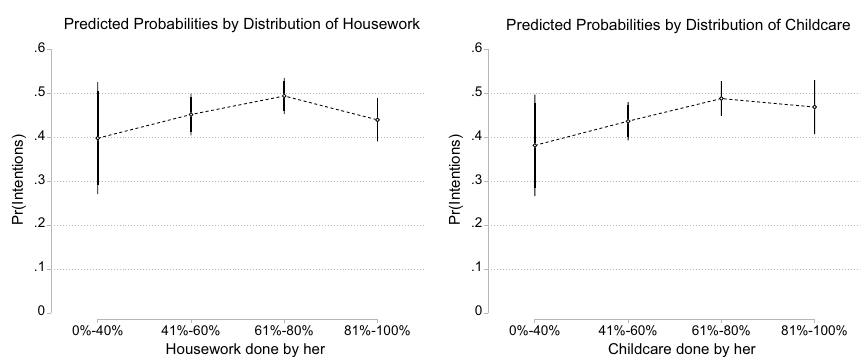
Fig. 6 Predicted probabilities of one-child mothers’ fertility intentions by woman’s proportion of total burden. Error bars at 90% (thin) and 95% (thick). Models control for housework/childcare duties done by other individuals, woman’s age, child’s age, migrant background, women’s attachment to the labour force, men’s labour force status, partners’ educational attainment, differences in educational attainment, partner’s children and partnership